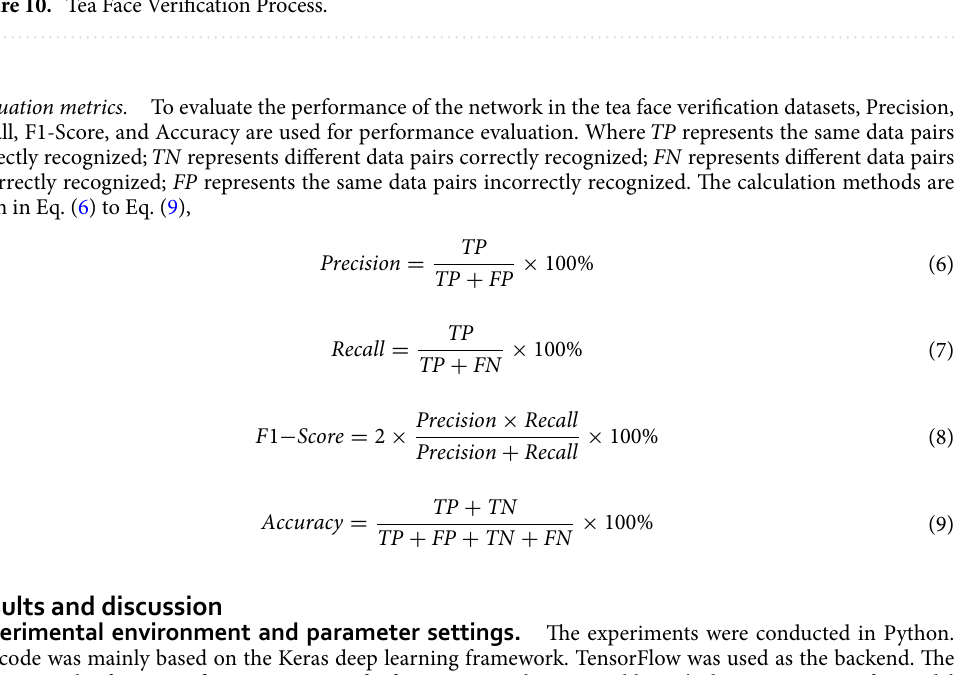
Figure 10. Tea Face Verification